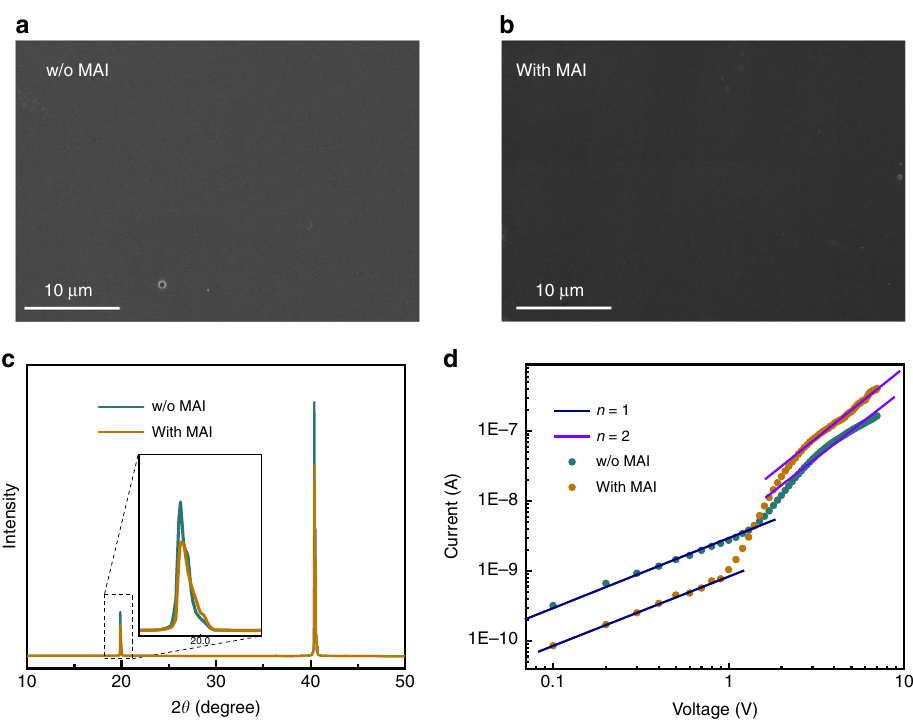
Fig. 4 Characterization of single crystals surface. SEM images of the MAPbI 3 single crystal surface a without and b with MAI treatment. c XRD patterns of MAPbI 3 single crystal, d SCLC without and with MAI treatment.